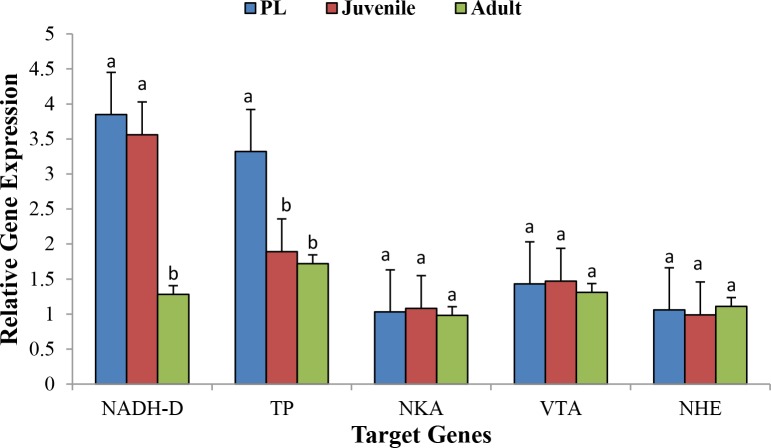
Relative gene expression of five target genes at 3 different life stages of M. koombooloomba (including seven biological replicates for each stage).Whole body of PL was used while pooled tissues were used for juvenile and adults. Relative gene expression values of candidate genes were normalized using 18S as a reference gene. Error bars represent ±1 SE.